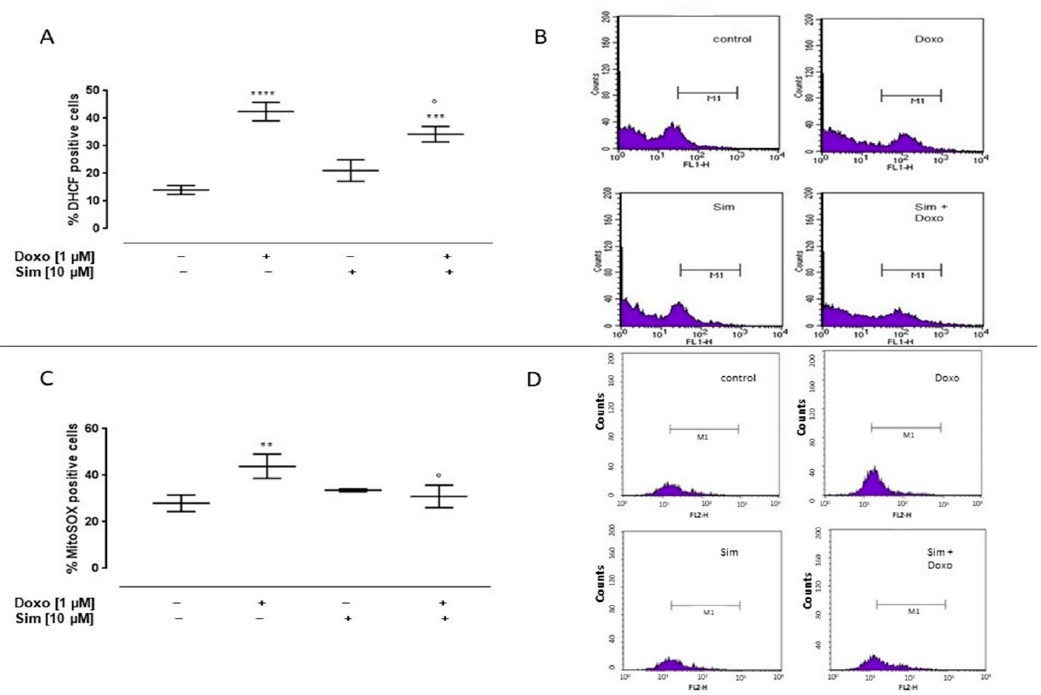
Figure 1. Effect of Simvastatin on Doxorubicin-induced cytosolic and mitochondrial ROS production. H9c2 cells were pre-treated with Sim (10 µM) for 4 h and then co-exposed to Sim and Doxo (1 µM) for 20 h. The fl uorescent probe 2 ′ ,7 ′ -dichloro fl uorescein diacetate (H 2 DCF-DA) was used to evaluate cytosolic ROS generation by fl ow cytometry analysis. Results are reported as mean ± S.E.M. of DCF- positive cells’ percentage of at least three independent experiments, each performed in duplicate ( A ).